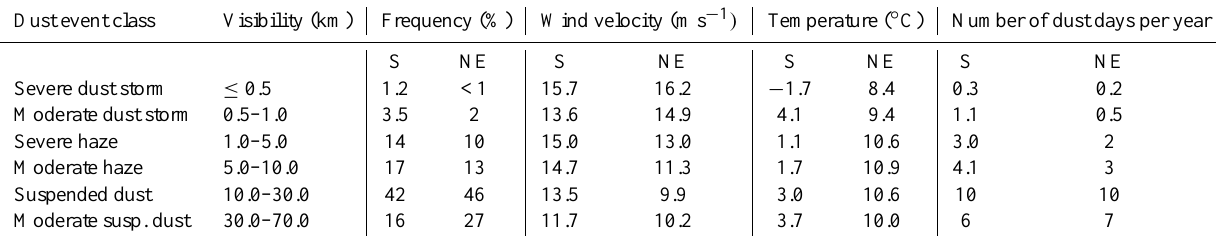
Table 2. Dust event classification based on visibility criteria. Frequency of dust events, mean wind velocity, mean temperature, and annual number of dust days of each dust class are included. S is the southern part and NE the northeastern part of